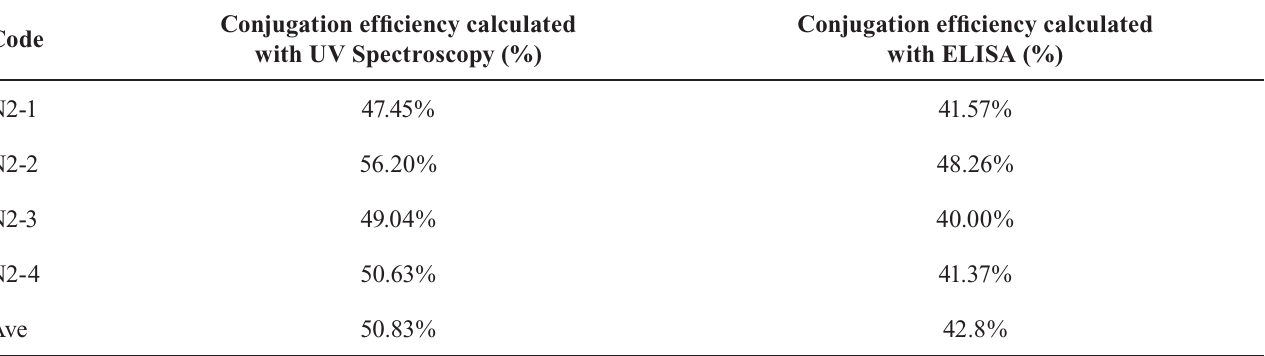
TABLE III - Comparing of conjugation efficiency calculated with UV Spectroscopy and ELISA for N2-code of antibody conjugated nanoparticles